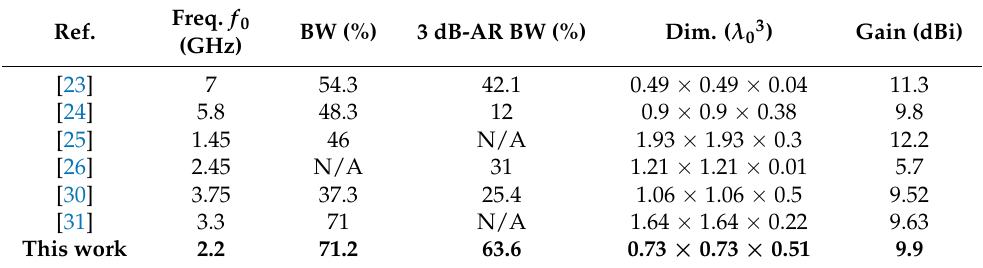
Table 2. Comparison with related